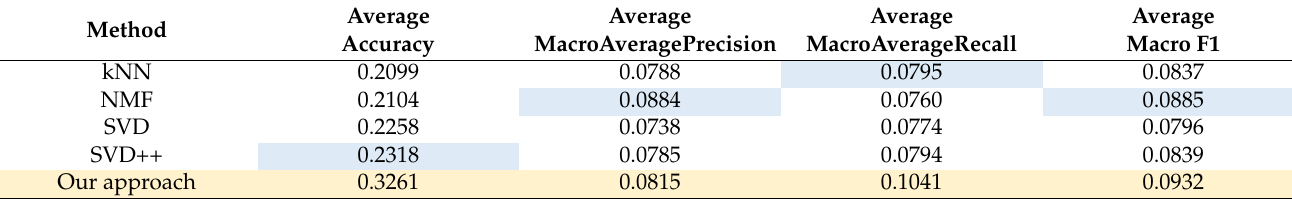
Table 10. Comparison of our proposed approach with other approaches in Experiment